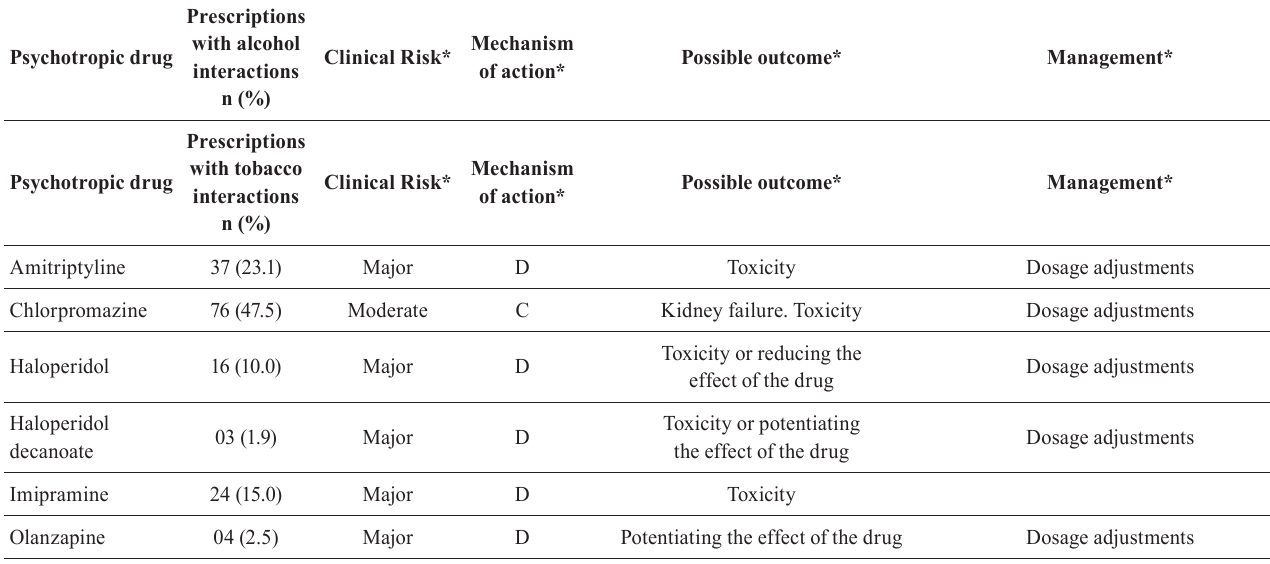
TABLE II - Frequency of prescriptions with drug interactions between psychotropics drugs and alcohol and tobacco